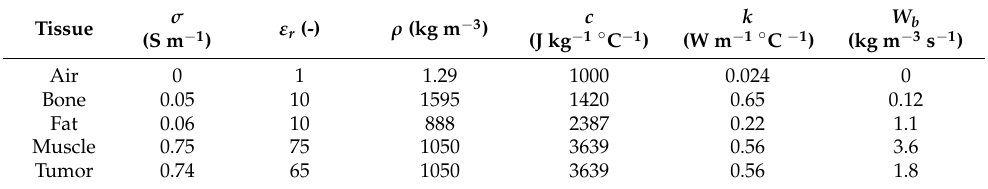
Table 1. Values of the dielectric and thermal tissue properties at 70 MHz used in the